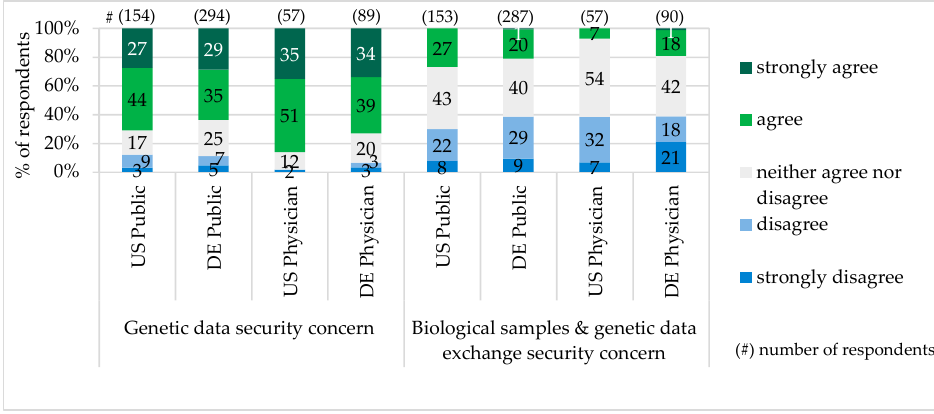
Figure 4. Concern about Genetic Data Security.